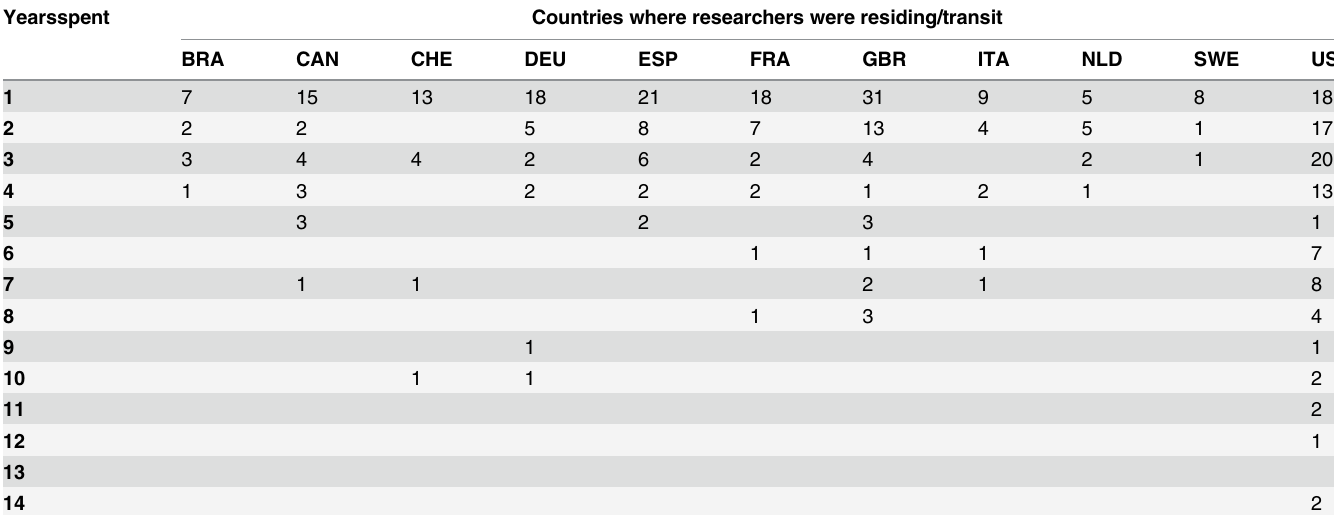
Table 14. Distributions of researchers in biological sciences by years spent in foreign institutions. Yearsspent